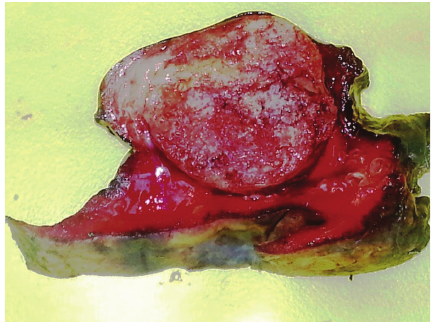
Figure 2: Circumscribed solid tumor mass surrounded by lung tissue.